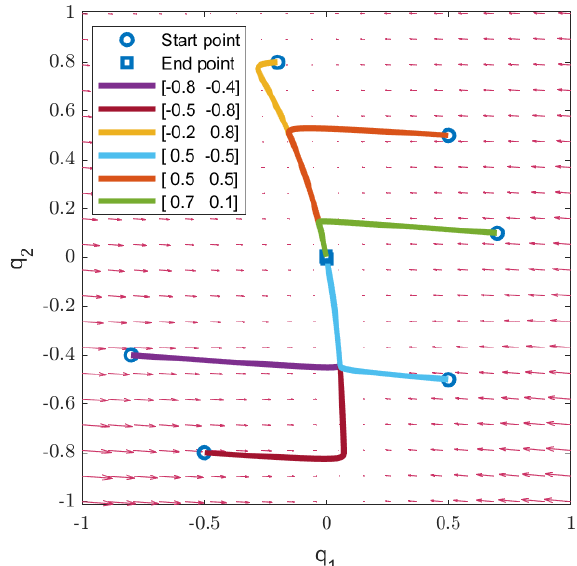
Figure 3. The phase plot of the control results in Example 2.